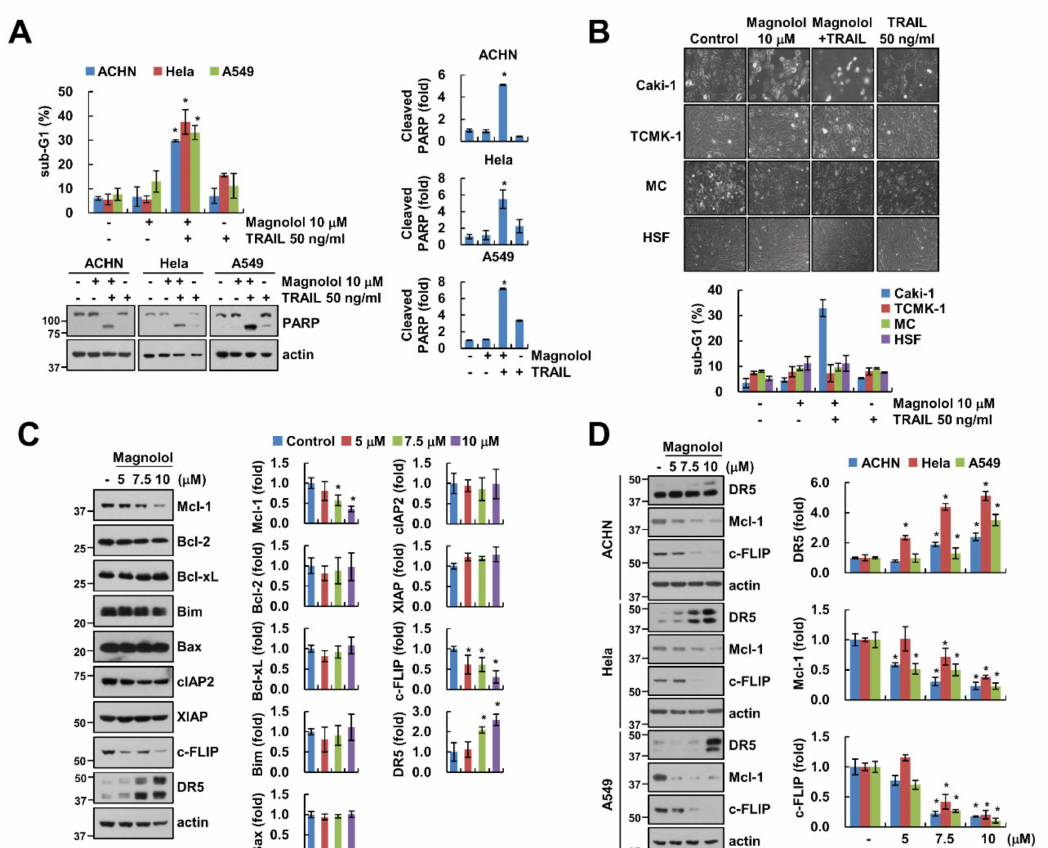
Figure 2. E ff ect of magnolol on TRAIL-induced apoptosis in other cancer and normal cells. ( A , B ) Indicated cancer ( A ) and normal cells ( B ) were treated with 10 µ M magnolol alone, 50 ng / mL TRAIL alone or magnolol plus TRAIL for 24 h. ( C , D ) Caki-1 ( C ) and indicated cancer cells ( D ) were treated with various concentrations of magnolol for 24 h. The sub-G1 population and protein expression were detected using flow cytometry ( A , B ) and Western blotting ( A , C , D ), respectively. Cell morphology was examined using interference light microscopy ( B ). The values in graph ( A – D ) represent the mean ± SD of three independent experiments. * p < 0.01 compared to the